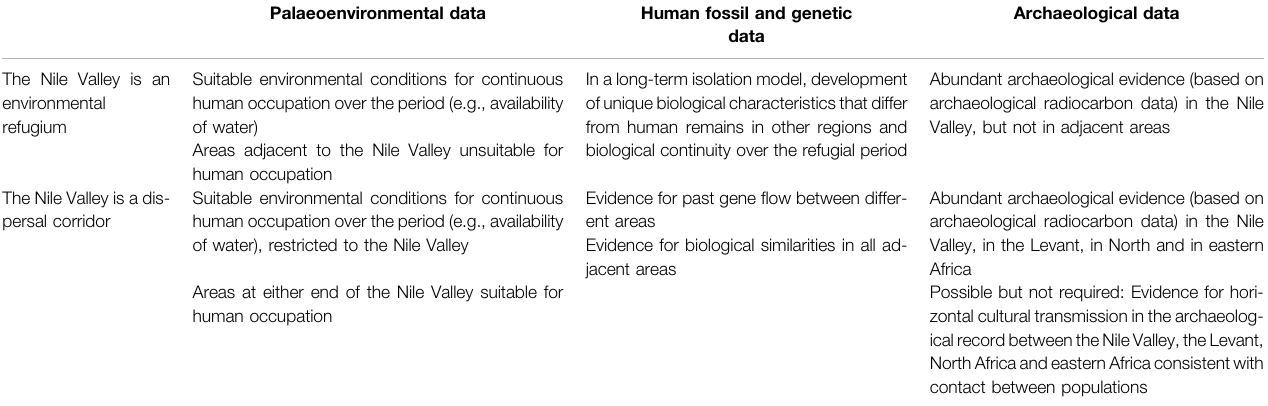
TABLE 1 | General expectations under a refugium or dispersal corridor